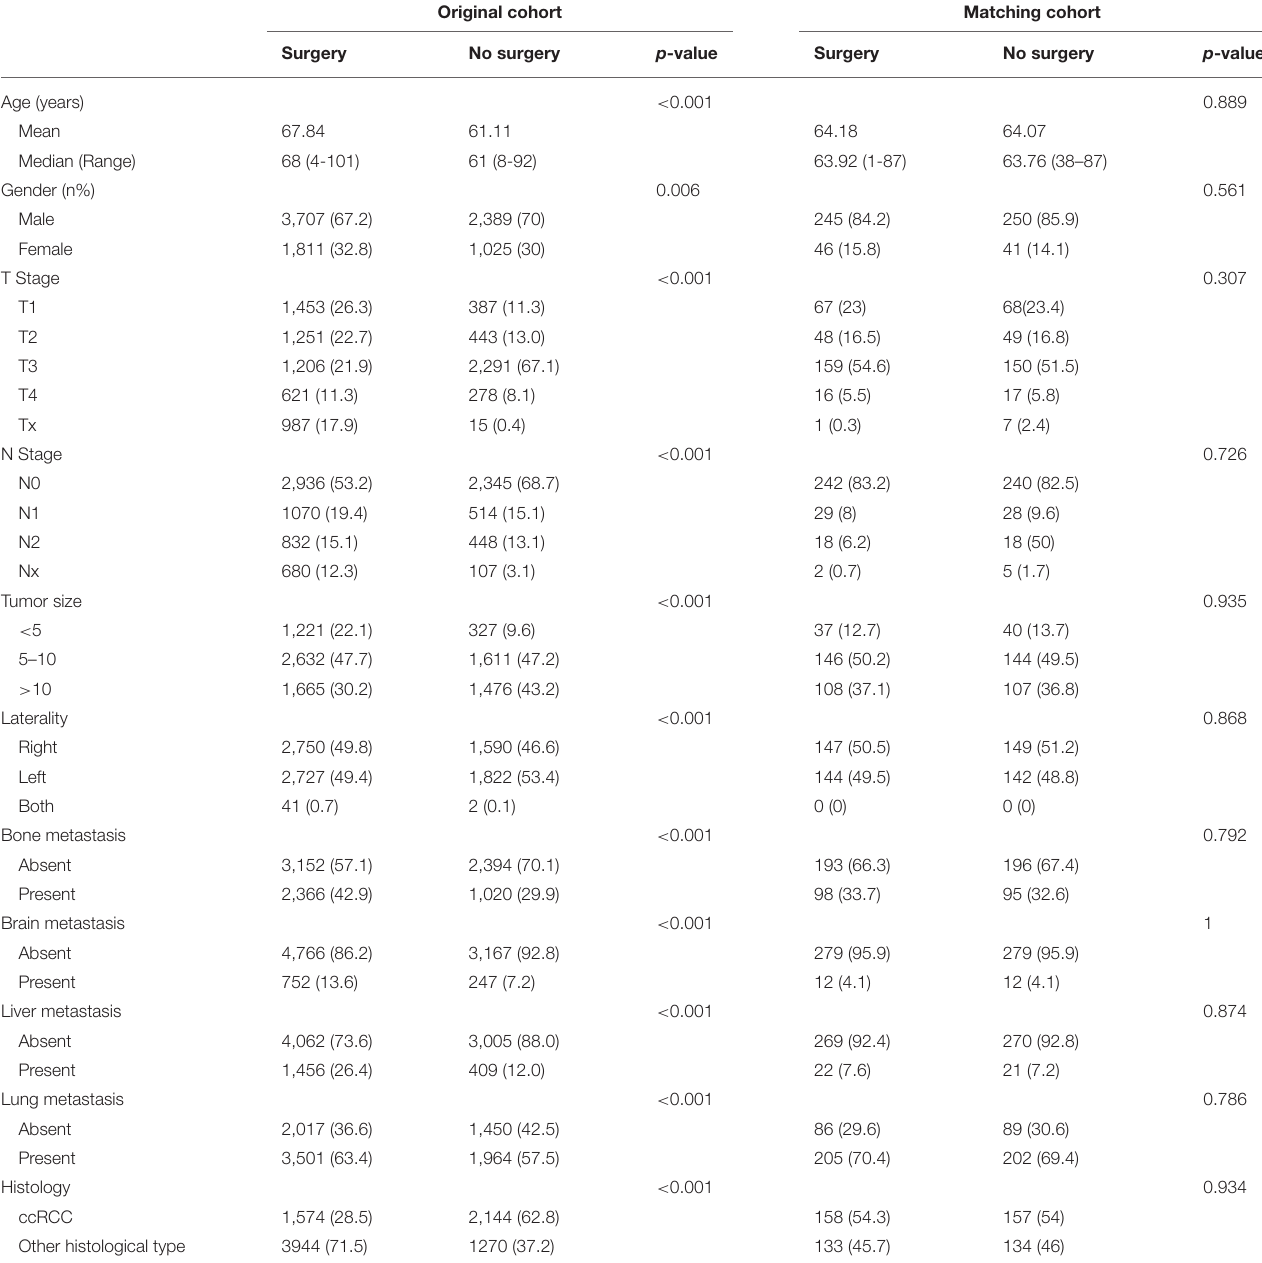
TABLE 1 | Patients characteristics between surgery and no surgery group. Original cohort Matching cohort Surgery No surgery p -value Surgery No surgery p